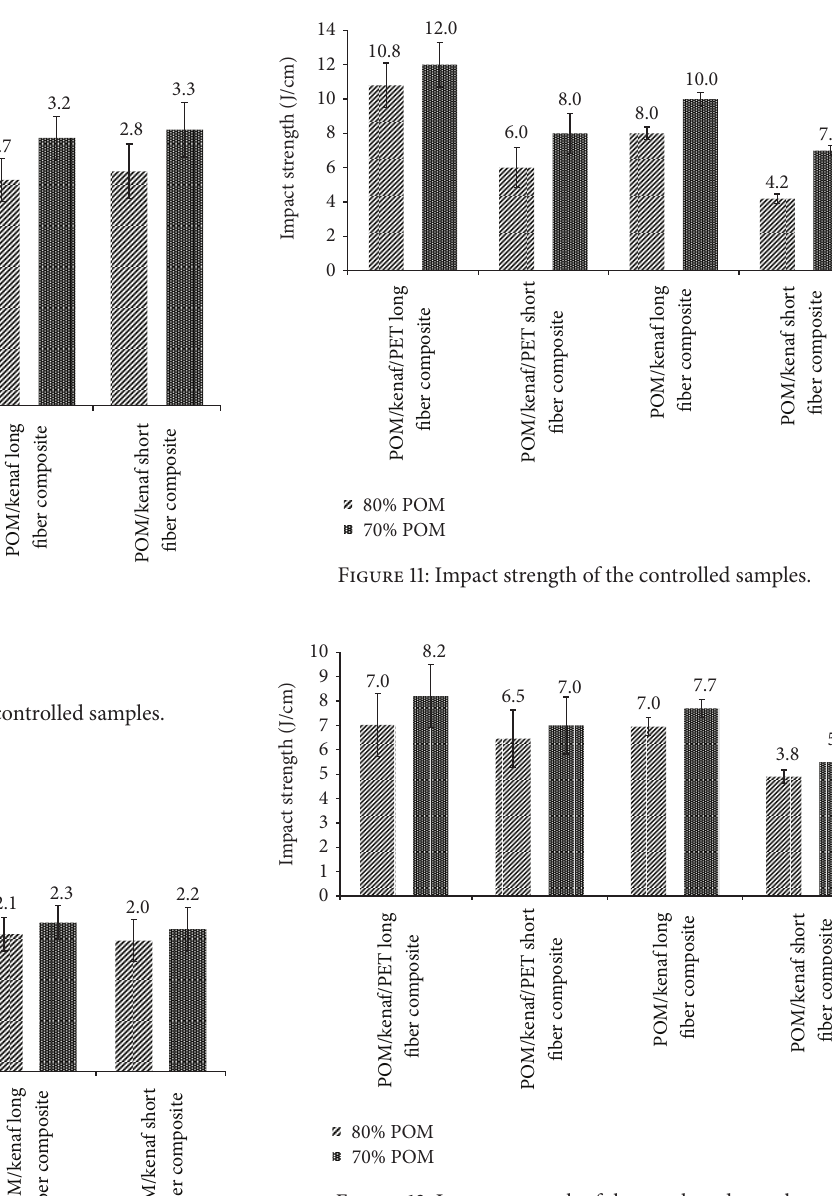
Figure 12: Impact strength of the weathered